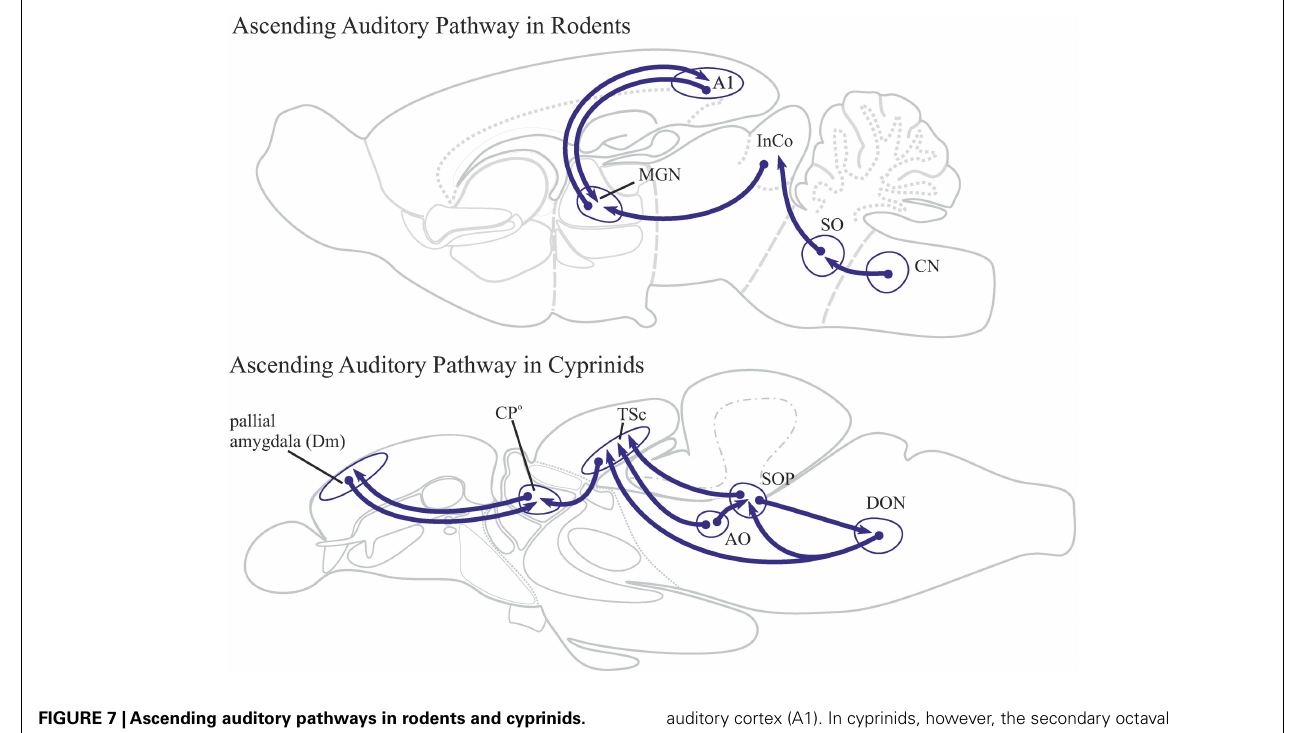
FIGURE 7 |Ascending auditory pathways in rodents and cyprinids. The ascending auditory pathway in cyprinids is similar to those found in mammals.The teleostean secondary octaval population (SOP) is homologous to the mammalian superior olive (SO).The supererior olive (SO) of rodents projects onto the inferior colliculus (IC), which conveys auditory information to the medial geniculate nucleus.The latter is a dorsal thalamic nucleus, which is reciprocally connected with the